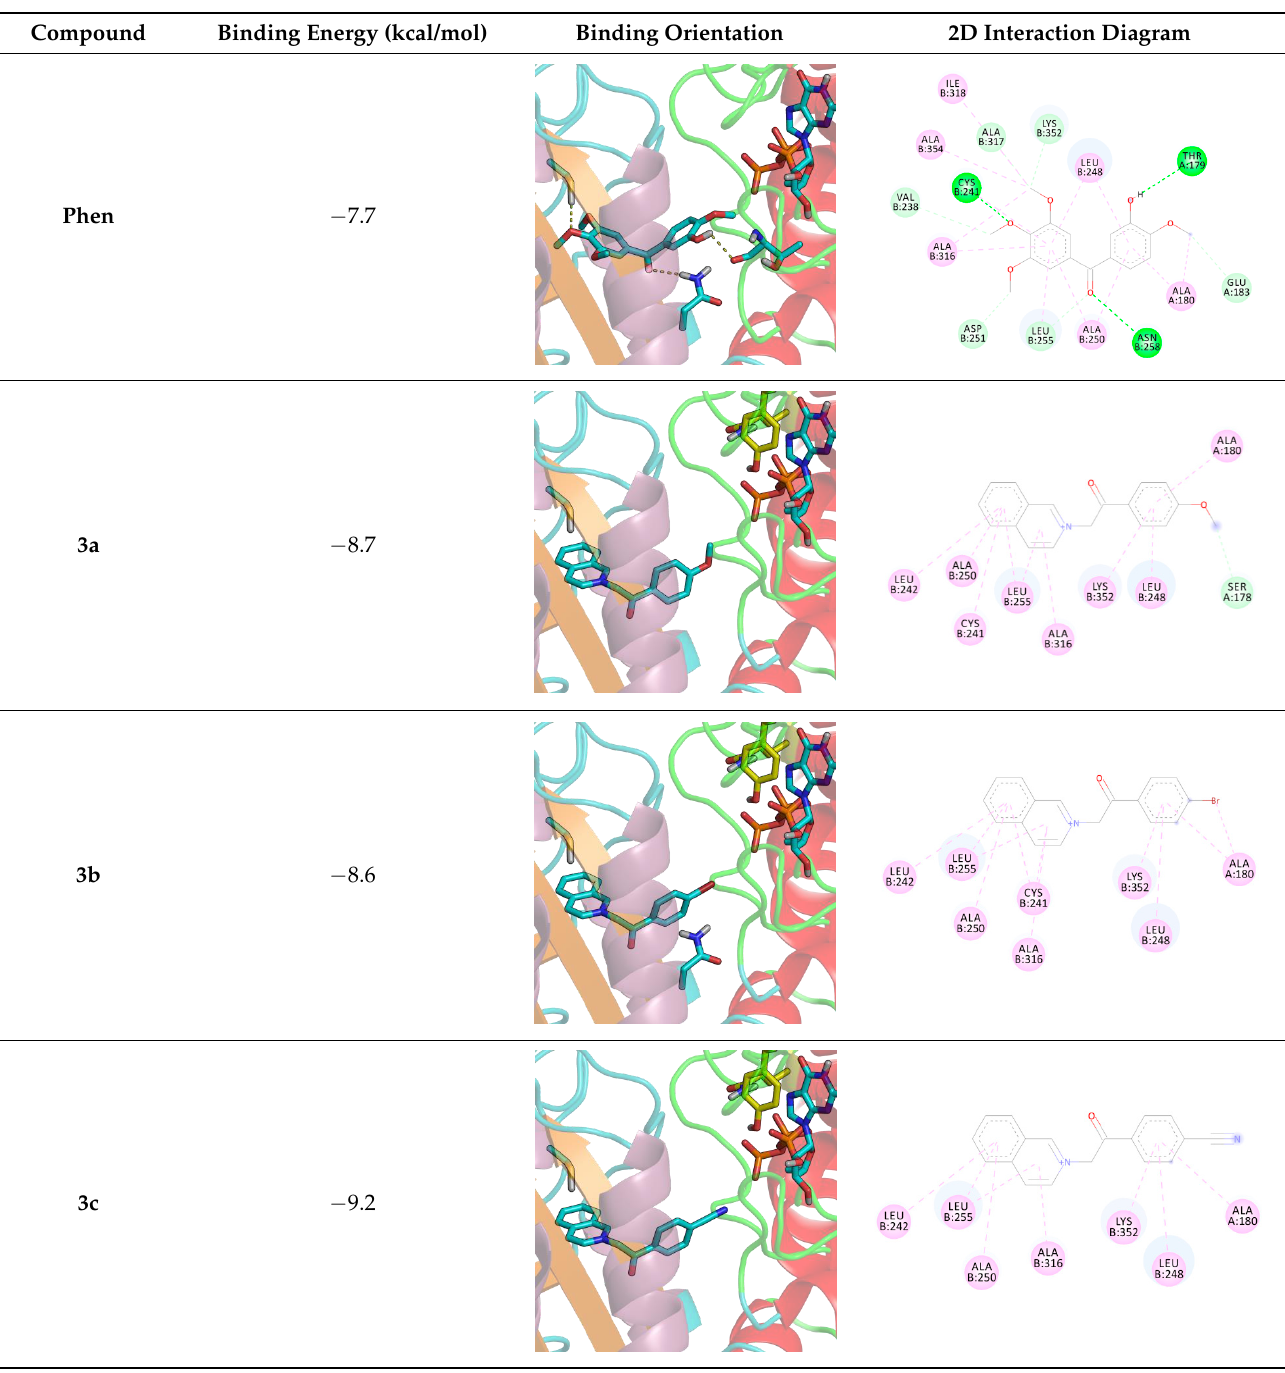
Table 6. Binding orientation, energy and amino acid contacts for tested compounds, as predicted by molecular docking experiments. For binding orientation, the α , β -tubulin heterodimer is shown as ribbons (red/yellow/green– α subunit helices/sheets/loops; pink/orange/magenta– β subunit helices/sheets/loops); relevant aminoacids, GTP and ligands are represented as sticks; for 2D interaction diagrams, colors are as follows: conventional hydrogen bonds–green, carbon- hydrogen bonds–pale green; hydrophobic interactions–light pink; amide-pi stacking–dark pink; pi-sigma stacking–purple.